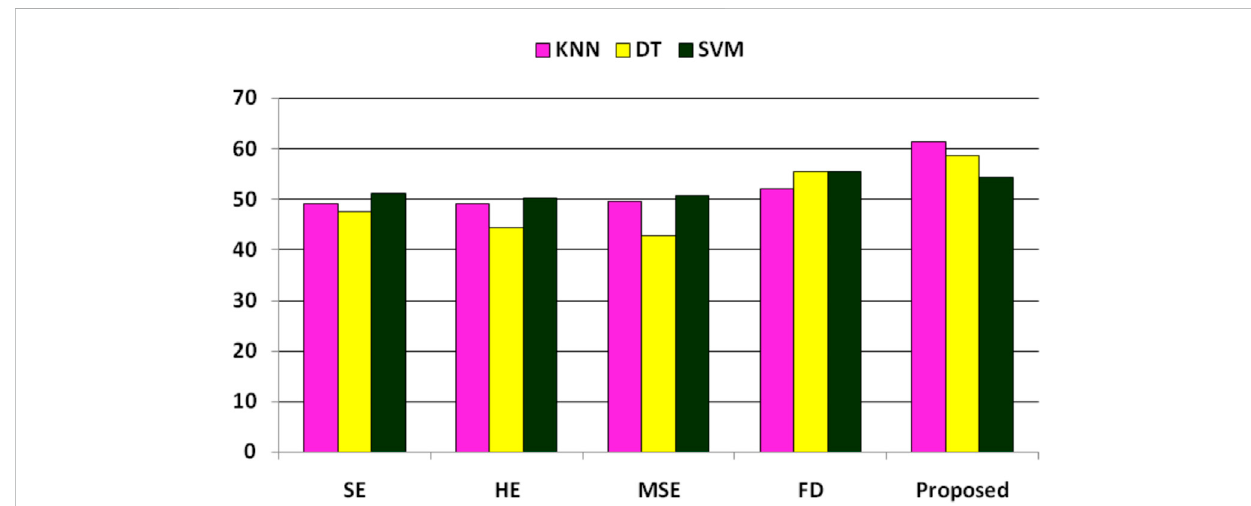
FIGURE 3 Performance (F1-score) comparison of existing features and the proposed features for the classi fi cation of essential genes of AT, DOM, DR, HS, and MM